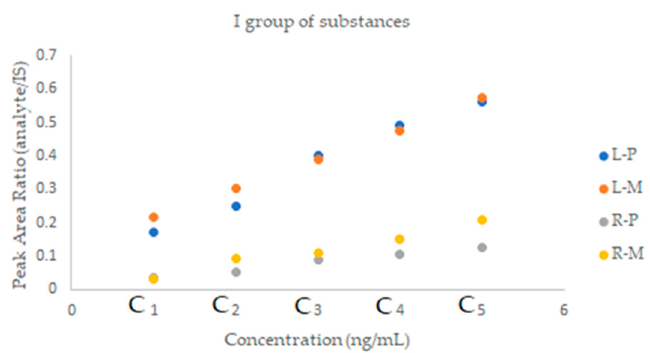
Figure 4. A graphical representation of the matrix effect between two parallel calibration curves for the I group substances, prepared without and with the matrix. P—samples without the matrix, M—samples with the matrix.